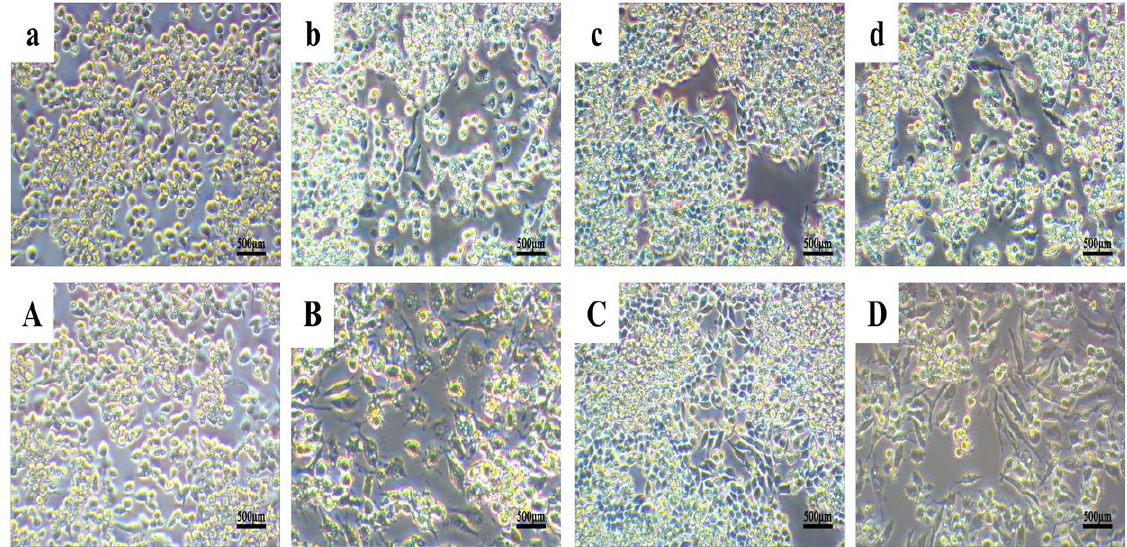
Figure 9. Changes in cell morphology under an electron microscope. Note: lowercase letters represent images from day 1 and uppercase letters represent images from day 3. ( a , A ) BLANK control group. ( b , B ) LPS treatment group. ( c , C ) KN-17 was added without LPS. ( d , D ) KN-17 was added at the same time.